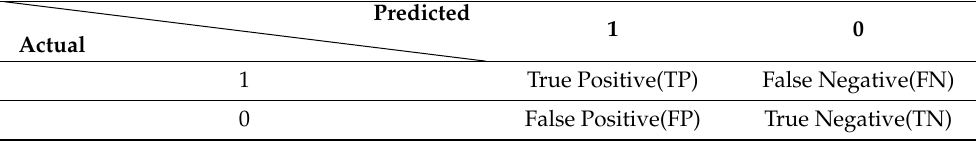
Table 3. Confusion